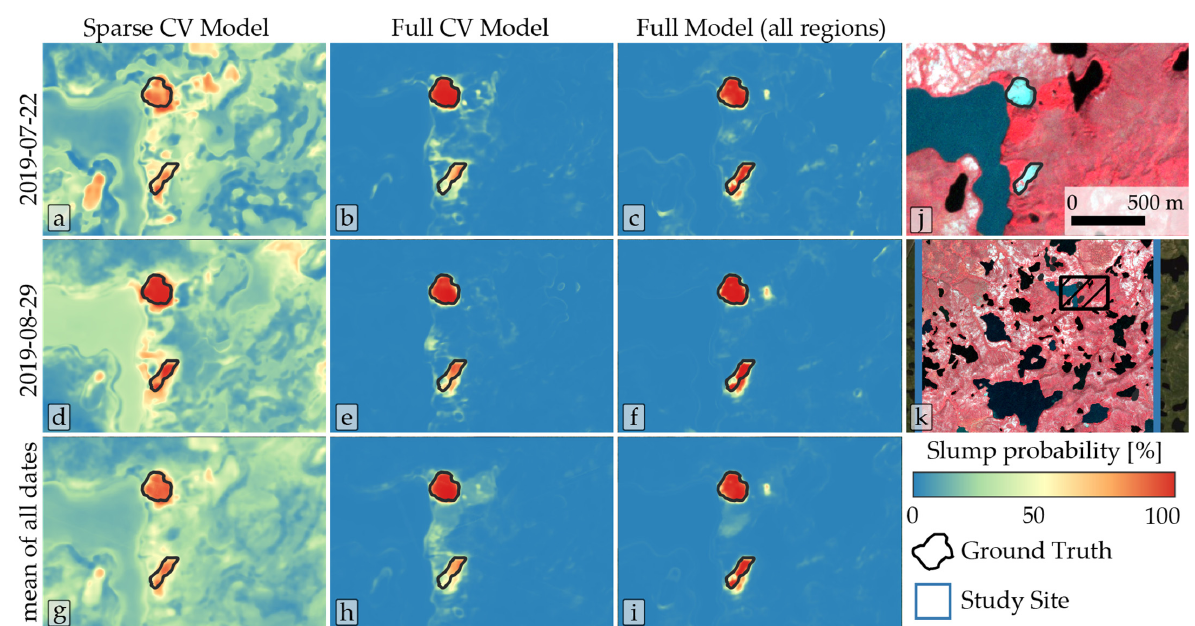
ground truth is shown in panel ( j ). Panel ( k ) shows the approximate location of the subset within the study region.